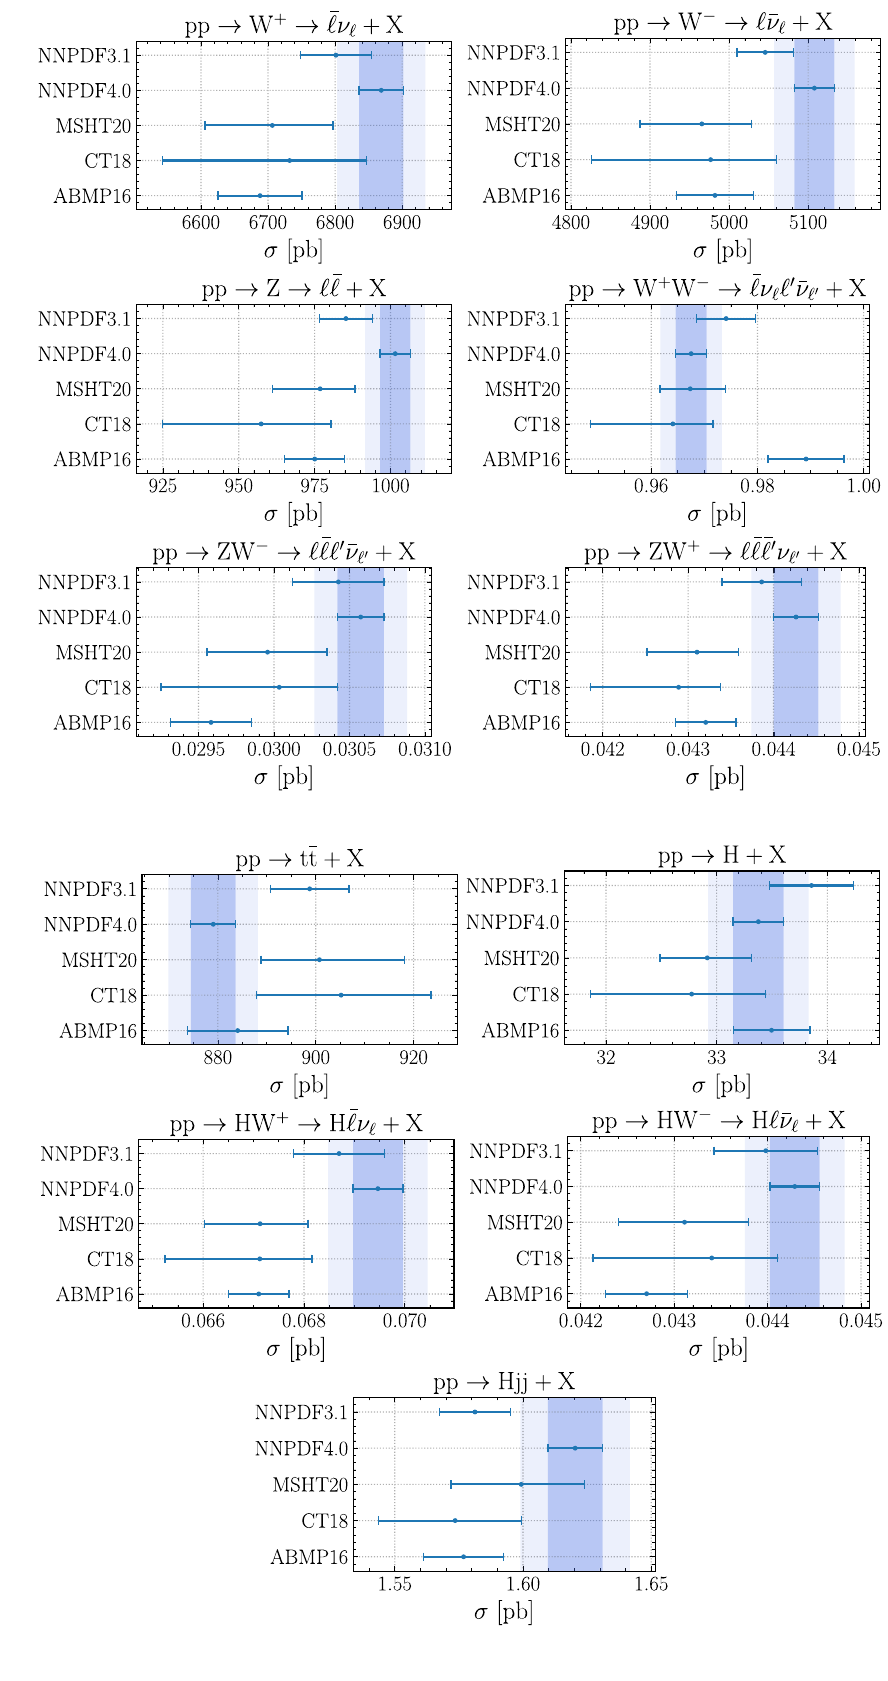
Fig. 61 Integrated LHC cross-sections at 14 TeV for neutral and charged-current Drell–Yan production (top) and gauge boson pair production (bottom) obtained with a variety of different PDF sets, all with α ( m ) = 0 . 118. The edges of s Z 1 σ and 2 σ PDF uncertainty bands for NNPDF4.0 are indicated by dark and light lines respectively